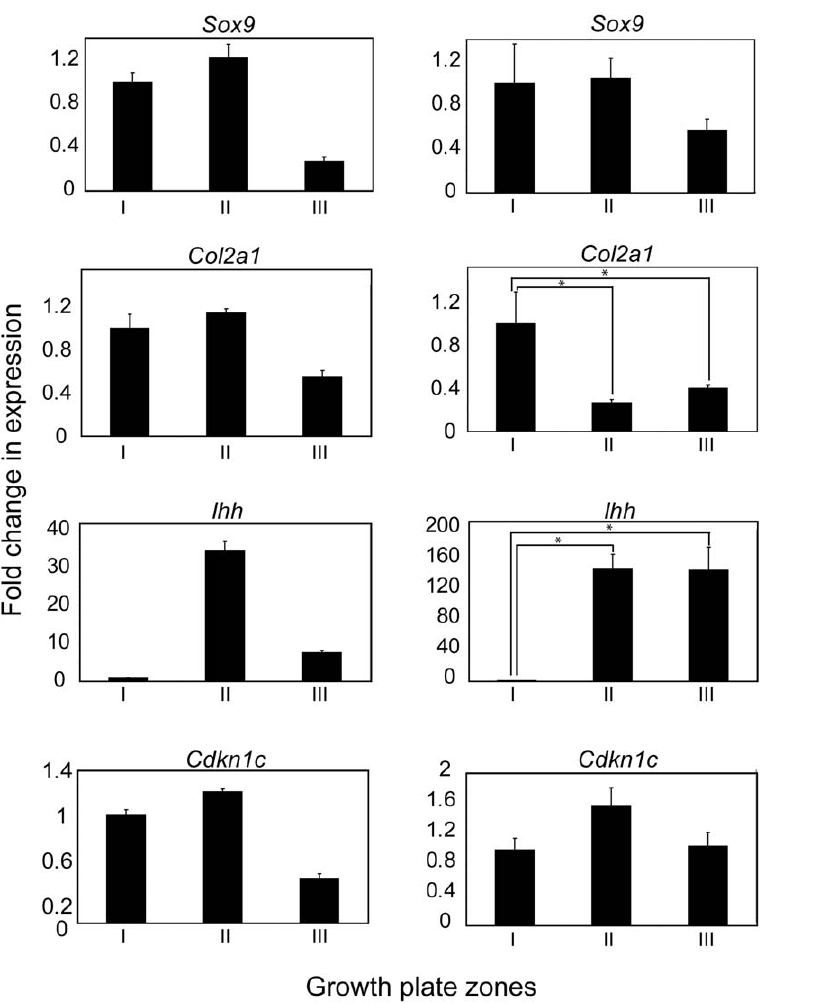
Figure 2. Real-time RT-PCR confirmation of early-stage markers of chondrocyte differentiation. Expression profiles of known chondrocyte markers were evaluated with qRT-PCR. Zone-specific expression of SRY (sex determining region Y)-box 9 ( Sox9 ), collagen 2 ( Col2a1 ), Indian hedgehog ( Ihh ) and cyclin-dependent kinase inhibitor 1c ( Cdkn1c, encoding p57 ) profiles are shown on the right, with the corresponding microarray data on the left. Four independent RNA isolations were evaluated for each probe and primer pair and p-values less than 0.05 were deemed significant.